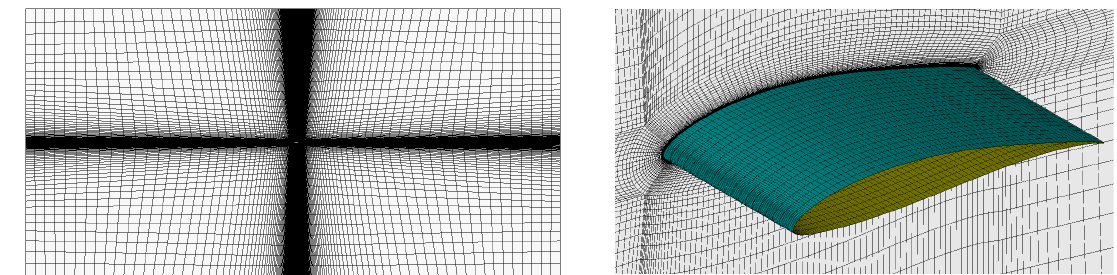
Figure 16. Structured mesh for CFD analysis.